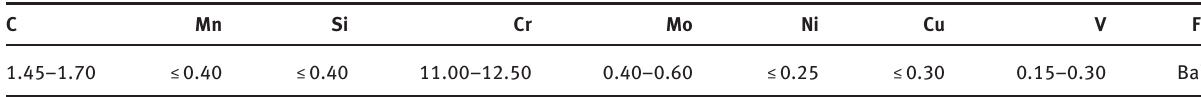
Table 1: Nominal chemical composition of Cr12MoV steel (wt%).